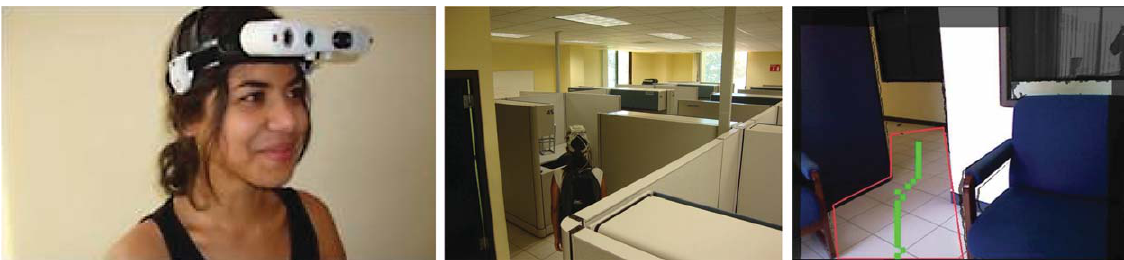
Fig. 2. System for blind guidance: (left) RBG − D sensor with two stereo cameras for 3 D dense point acquisition at short distances; (middle) navigation; (right) walking path